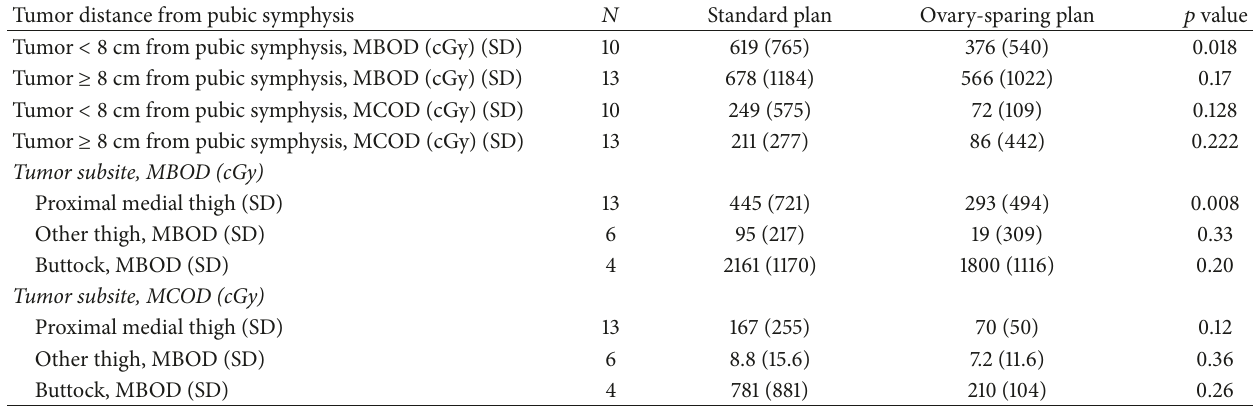
Table 3: Dosimetric comparison of mean bilateral ovary dose (MBOD) and mean contralateral ovary dose (MCOD) for standard plans and ovary-sparing plans by anatomic location ( 𝑛 = 23